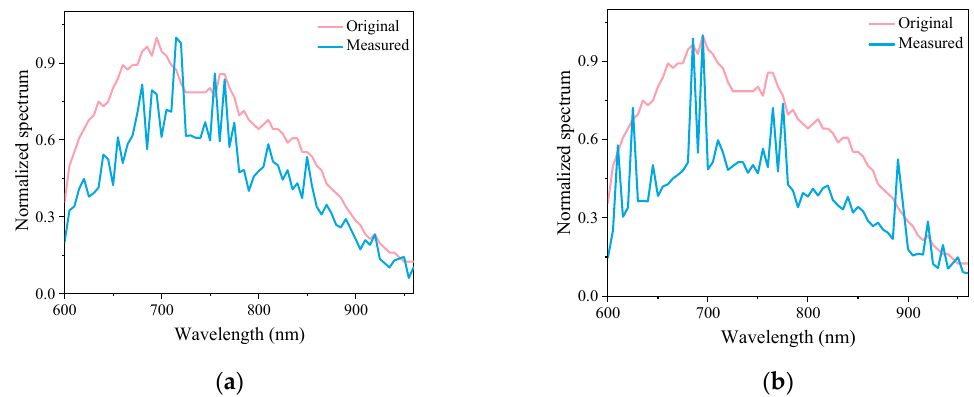
Figure 10. Comparison of target’s normalized spectra before and after being covered by two hyperspectral waveform decomposition methods: ( a ) proposed method; ( b ) waveform accumulation method.